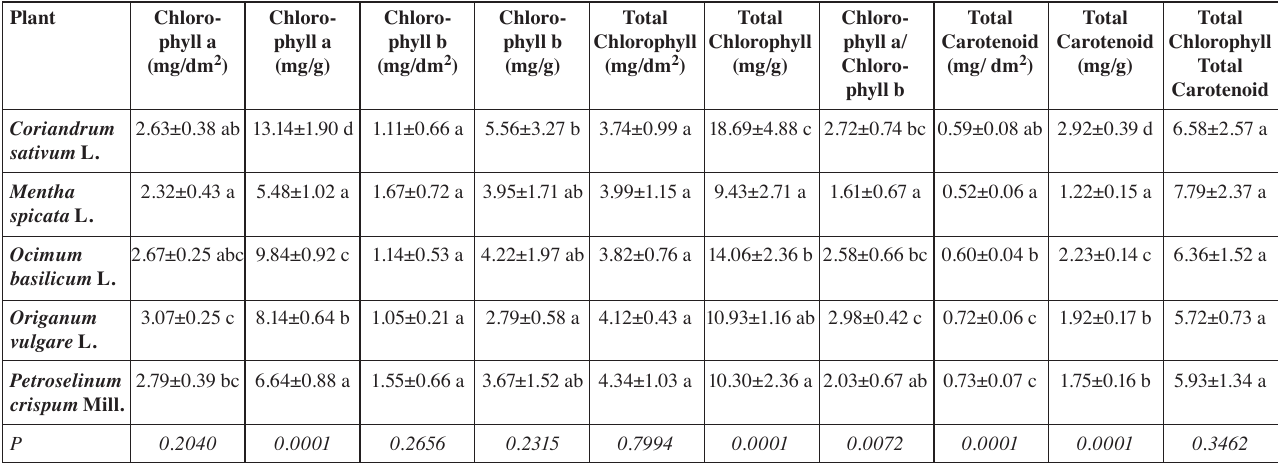
Tab. 2: Photosynthetic pigments (mg/g or mg/dm 2 of fresh weight) content of leaves of the five studied species of medicinal and aromatic plants (mean ± SD, n = 6).